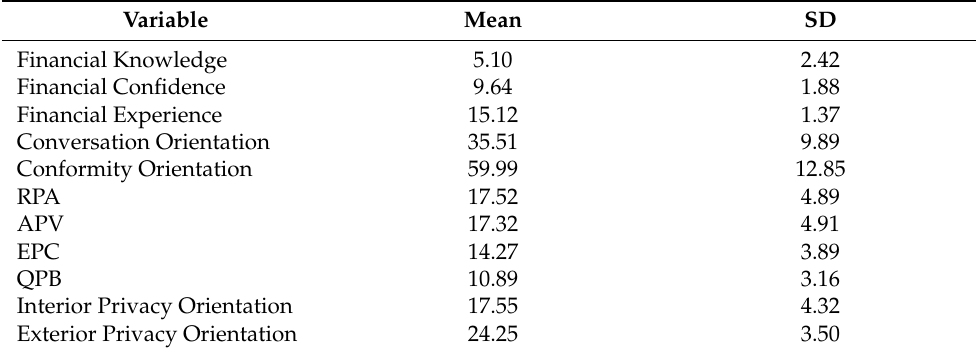
Table 3. Descriptive statistics of continuous variables.